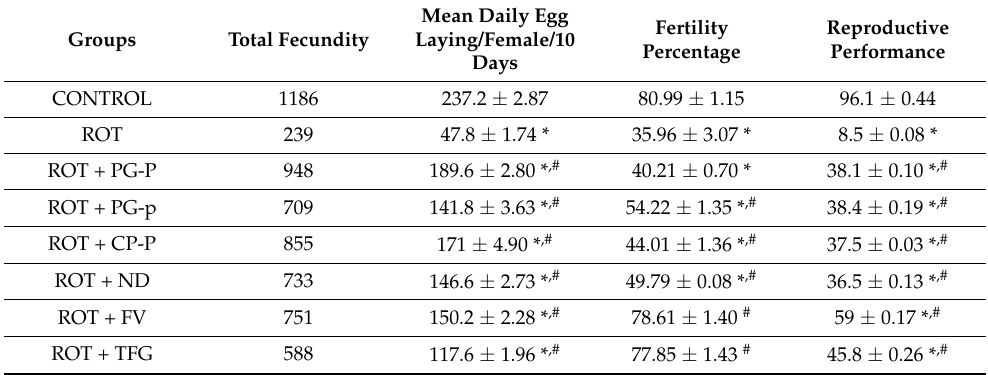
Table 1. Reproductive capacity of Oregon flies in control, ROT, and combinations of phytoextracts. Groups Total